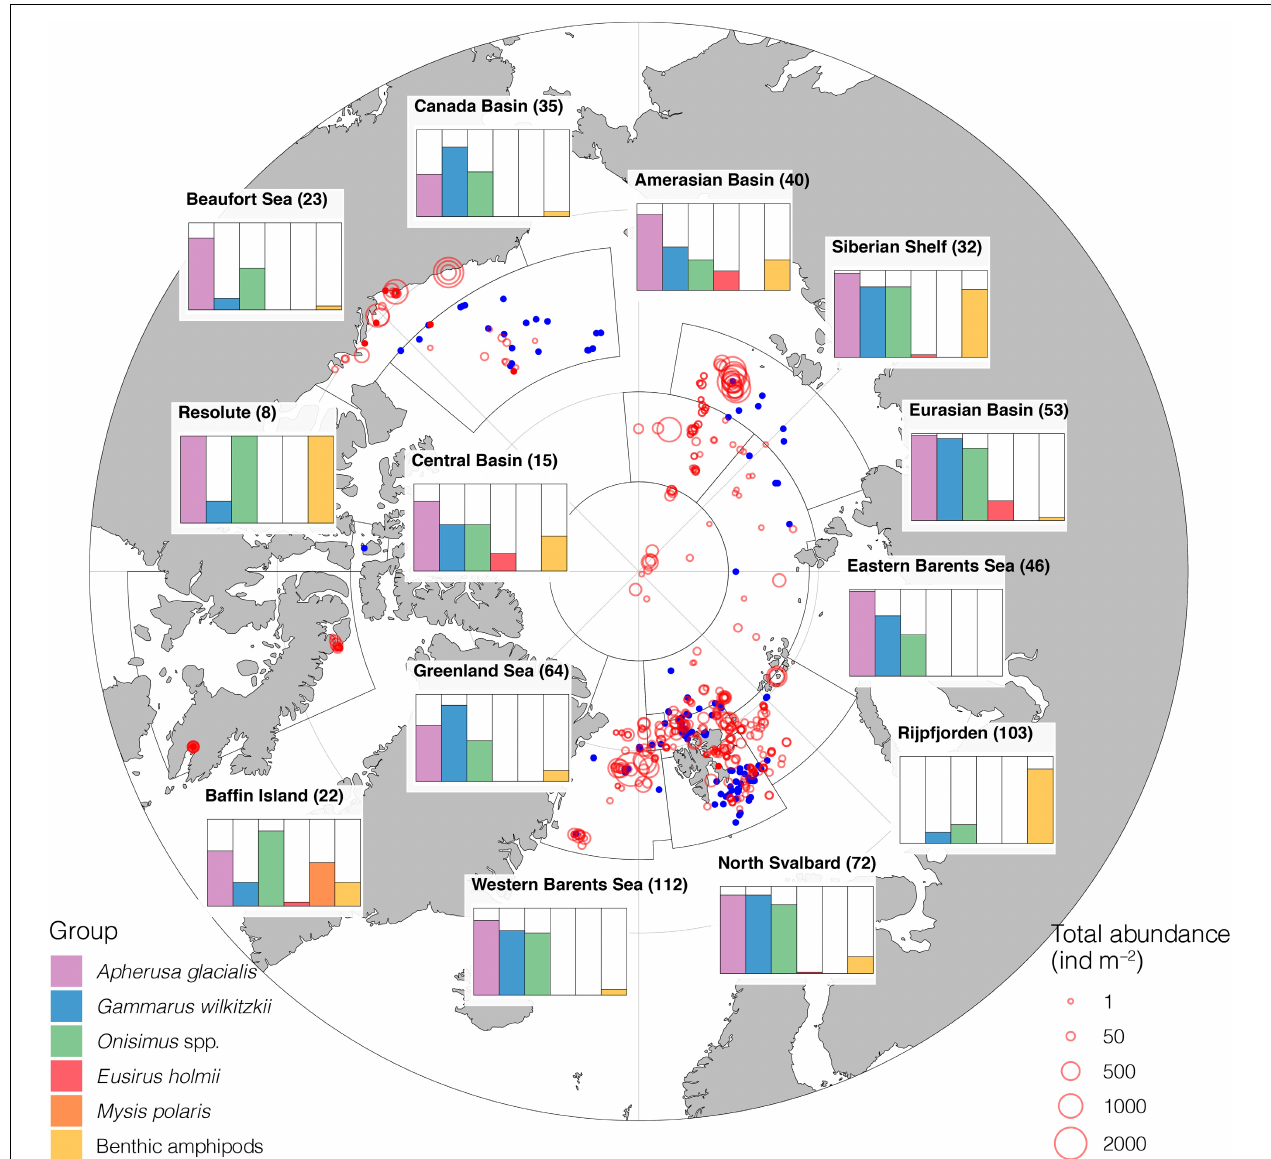
FIGURE 3 | Pan-Arctic distribution of sea-ice macrofauna (ice amphipods and mysids). Distribution and abundance across the Arctic were aggregated from 47 sources ( Table 1 ) between 1977 and 2012. Bar graphs illustrate the frequency of occurrence (%) of macrofauna in samples that contained at least one ice-associated crustacean. Red circles illustrate the total abundances of all ice-associated crustaceans in quantitative samples (ind. m − 2 ) at locations of sampling. Number of sampling efforts for each region is given in parenthesis after region name. Blue dots represent samples where only presence data were